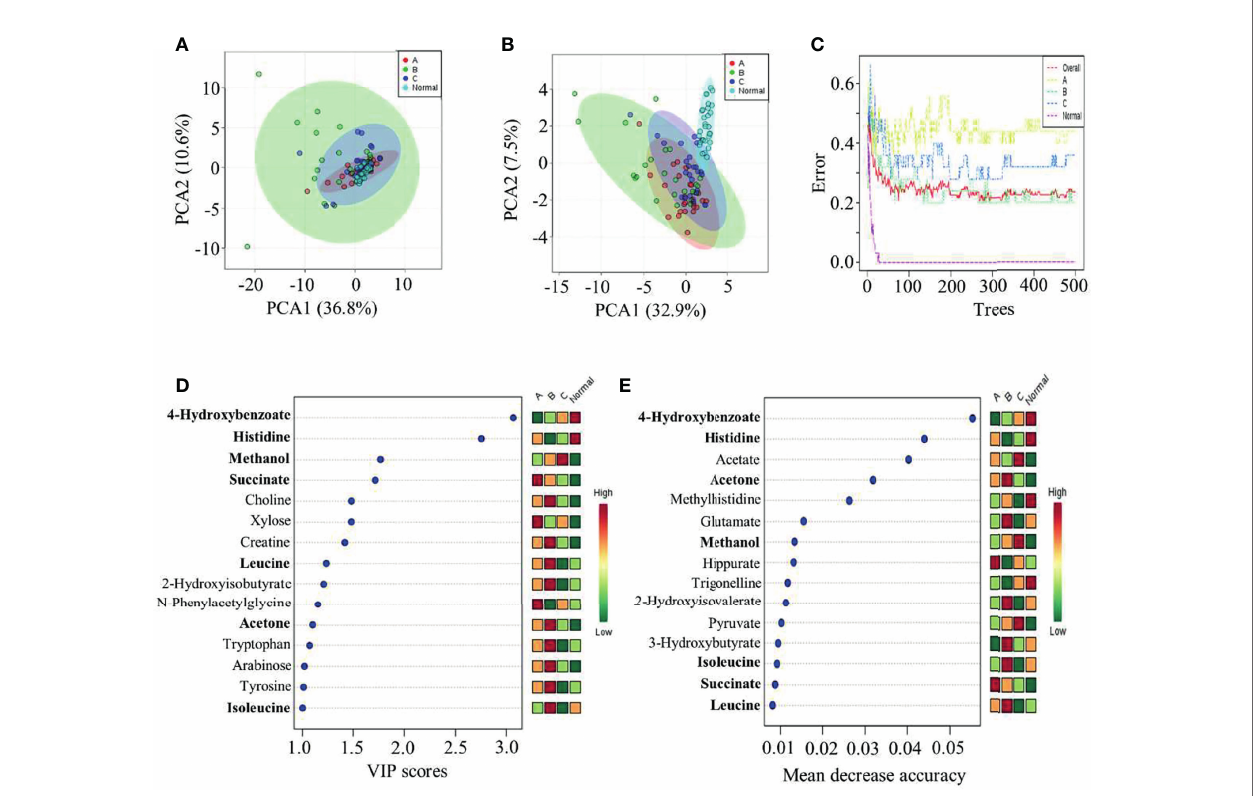
FIGURE 3 | Statistical comparison among the four clinical groups. (A) PCA, (B, D) PLS-DA, and (C, E) random forest tests were performed to identify group characteristics and potential metabolite biomarkers along with CRC treatment. Group A, CRC patients before surgery; Group B, CRC patients after surgery; Group C, CRC patients after chemotherapy; and Group N, healthy control